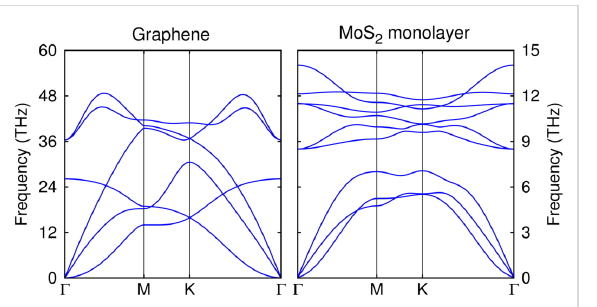
Figure 1: Dispersion relations for the phonon modes of single-layer graphene (left) and MoS 2 (right), from DFT calculations.